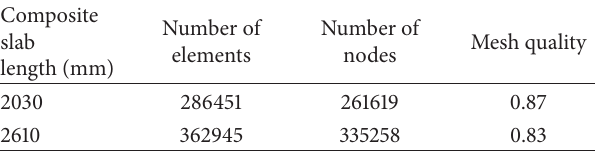
Figure 4: Composite slab geometry for m - k test. Detail of modelled geometry (in blue). Table 3: Finite element mesh properties.